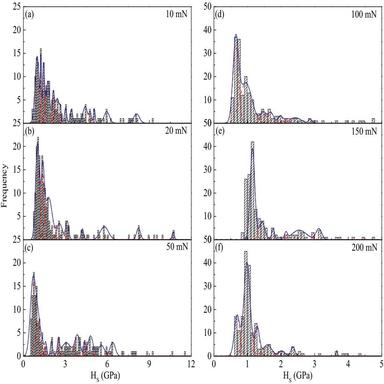
Hardness PDFs from the LIL scratches with different pre-designed loading levels: (a) 10 mN (b) 20 mN, (c) 50 mN, (d) 100 mN, (e) 150 mN and (f) 200 mN.